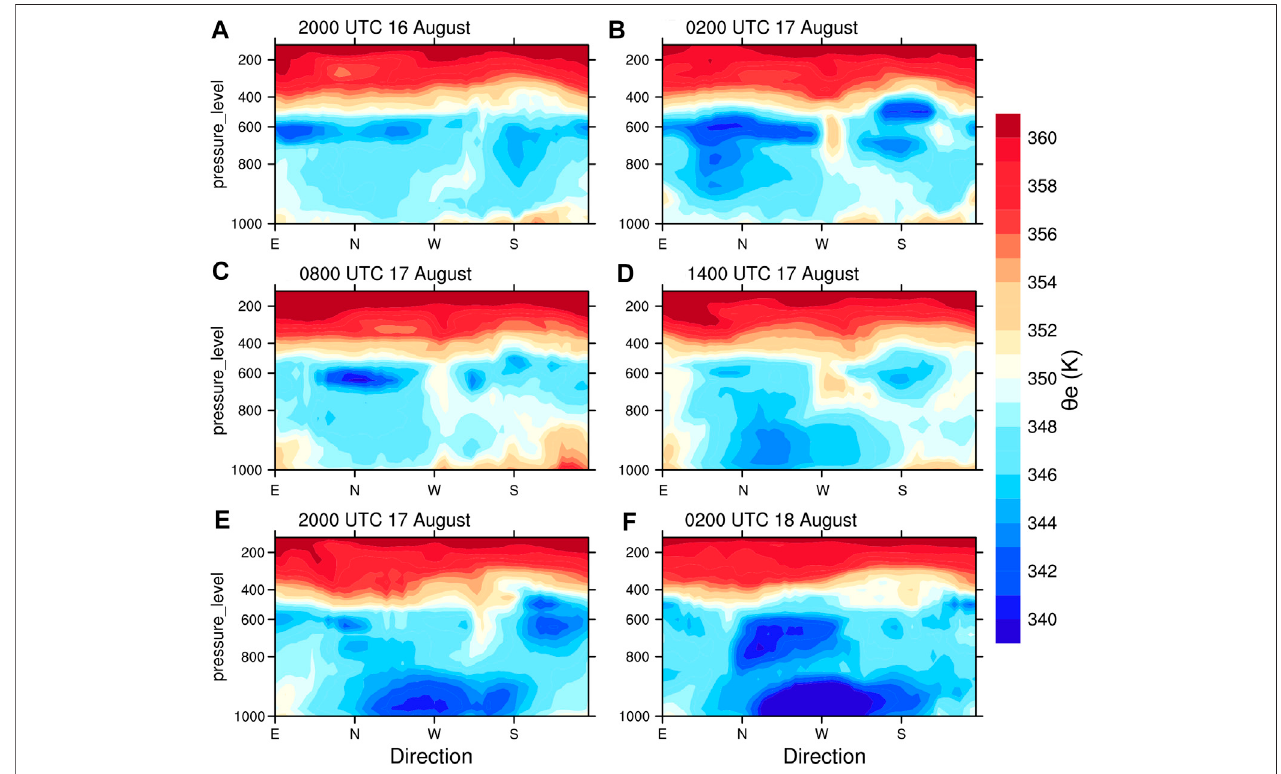
FIGURE11| Theverticalcross-sectionofequivalentpotentialtemperature(shading,K)averagedinanannulusbetweentheradiiof150and300 kmfromthestorm center: (A) 2000 UTC 16 August, (B) 0200, (C) 0800, (D) 1,400, (E) 2000 UTC 17 August, (F) 0200 UTC August 18, 2018.